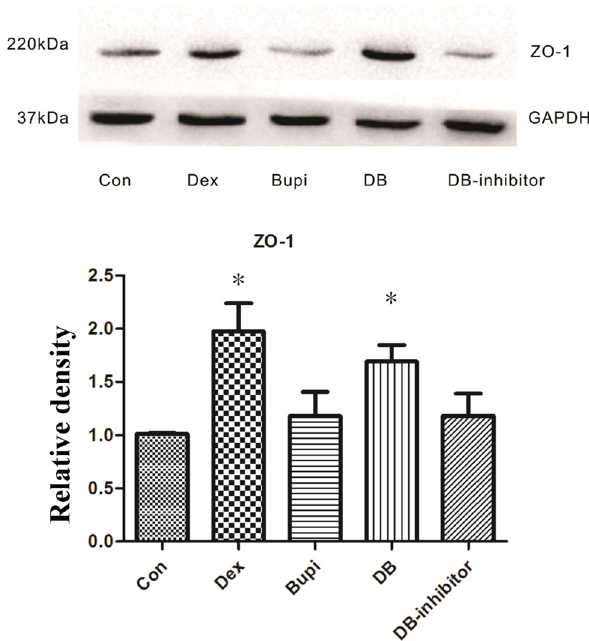
Figure 3: ZO - 1 protein expression. The protein expression levels of ZO - 1 in DB group and Dex group was higher than that in other three groups. * P < 0.05 vs Con, Bupi, and DB inhibitor.